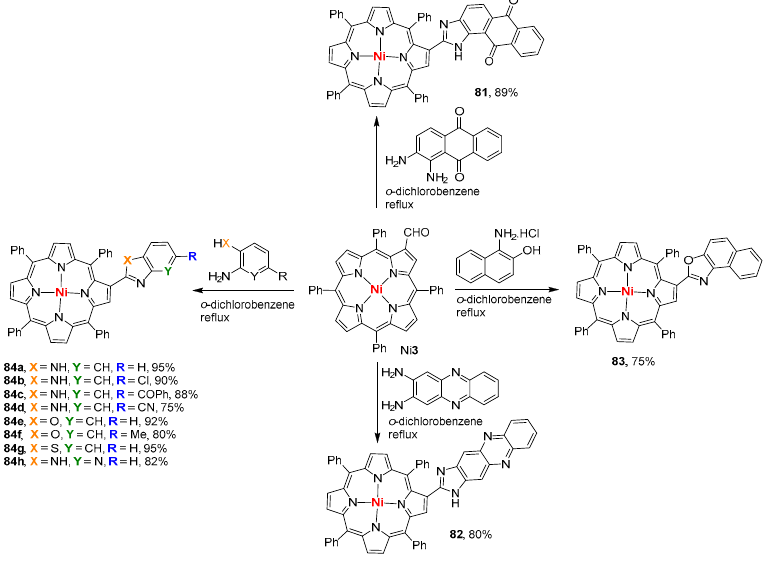
Scheme 20. Reaction of β -CHOTPP with o -arylenediamines, o -aminophenols, o -aminothiophenol